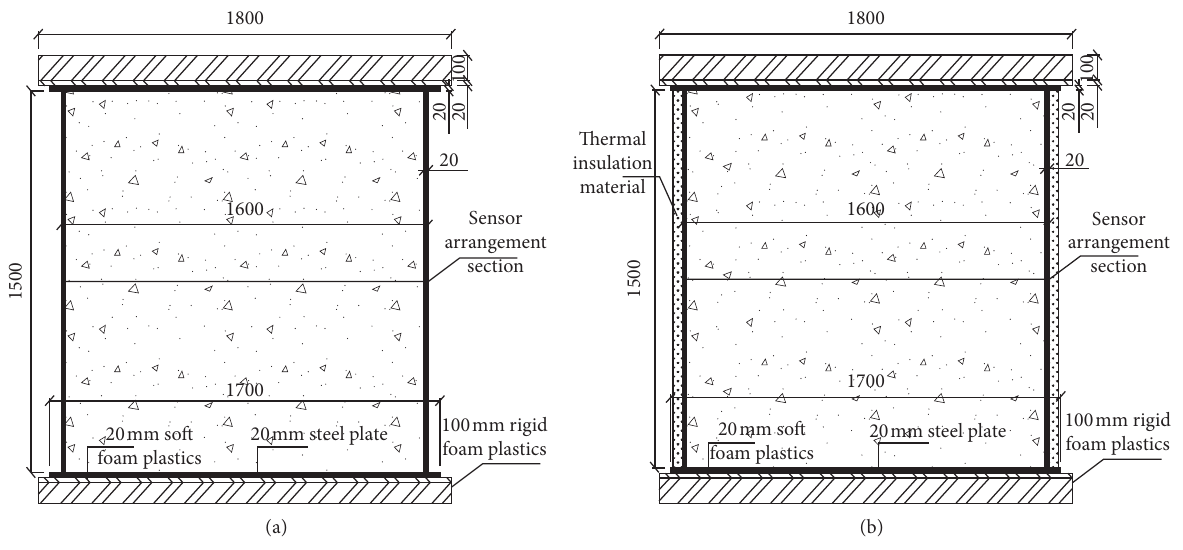
Figure 2: CFST member dimensions (mm). (a) CFST-1 (not insulated). (b) CFST-2